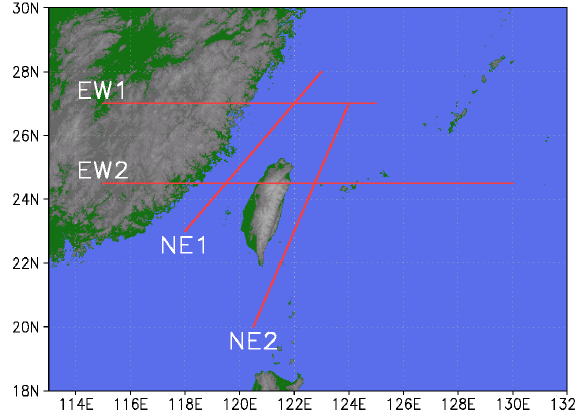
Fig. 9. Schematic illustration of cross-sections (NE1, NE2, EW1 and EW2) in this